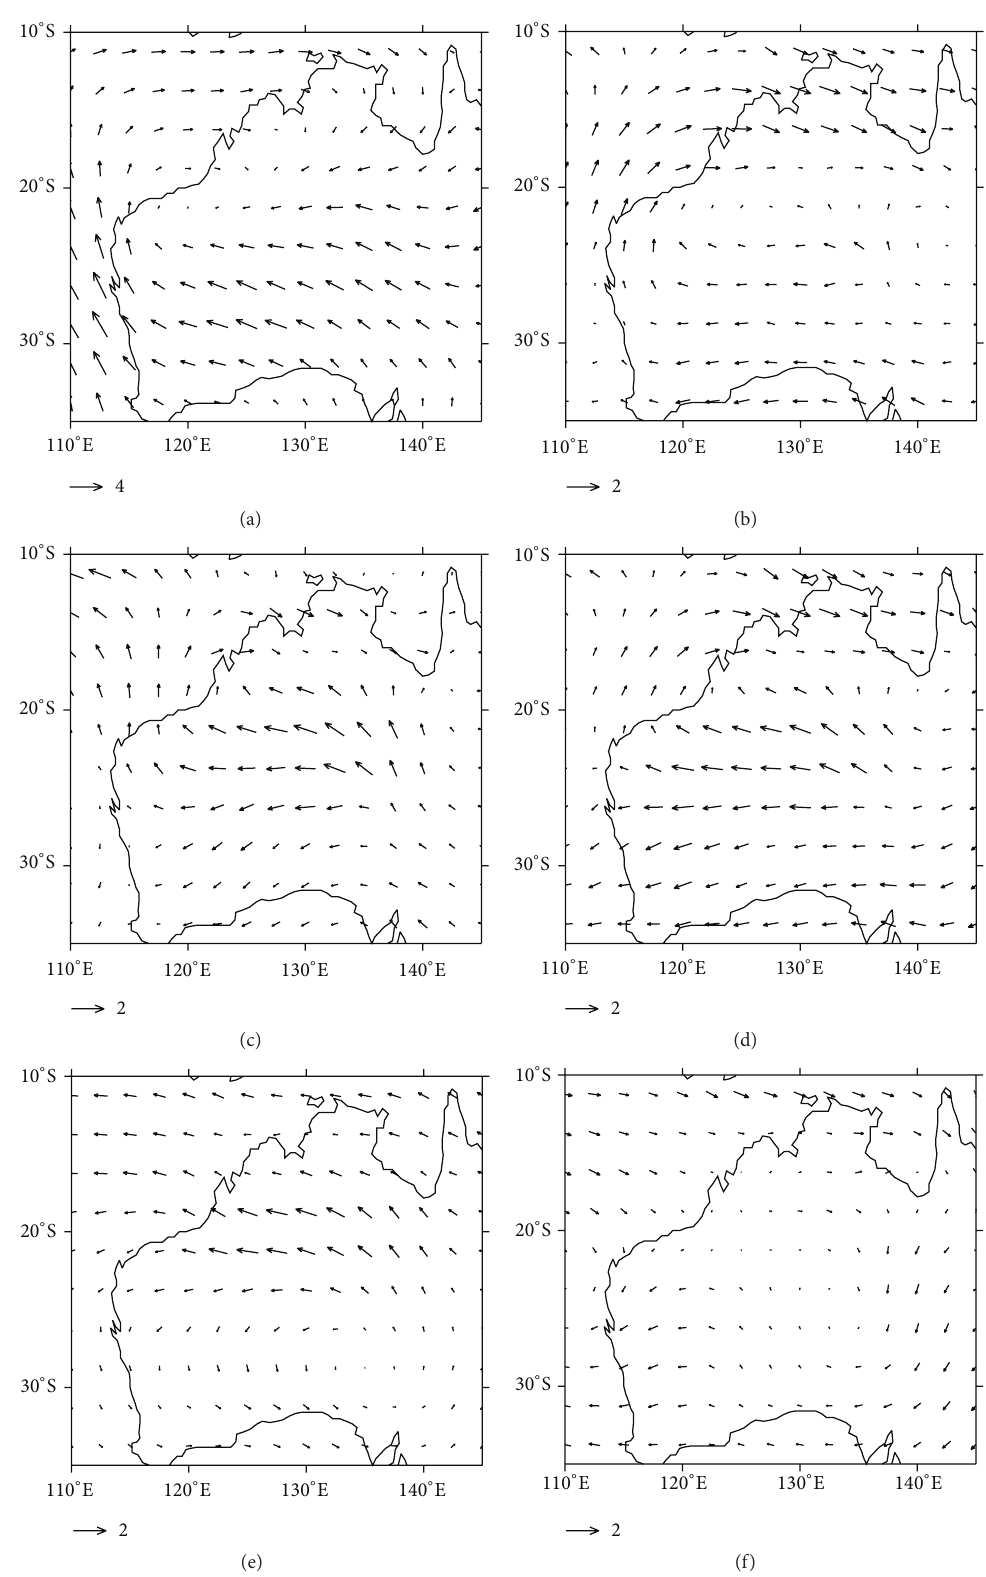
Figure 1: Climatological mean DJF circulation at 925 hPa (ms −1 ) for (a) ERA-Interim, (b) A1.0 minus ERA-Interim, (c) A1.1 minus ERA- Interim, (d) A1.3 minus ERA-Interim, (e) A1.1 minus A1.0, and (f) A1.3 minus